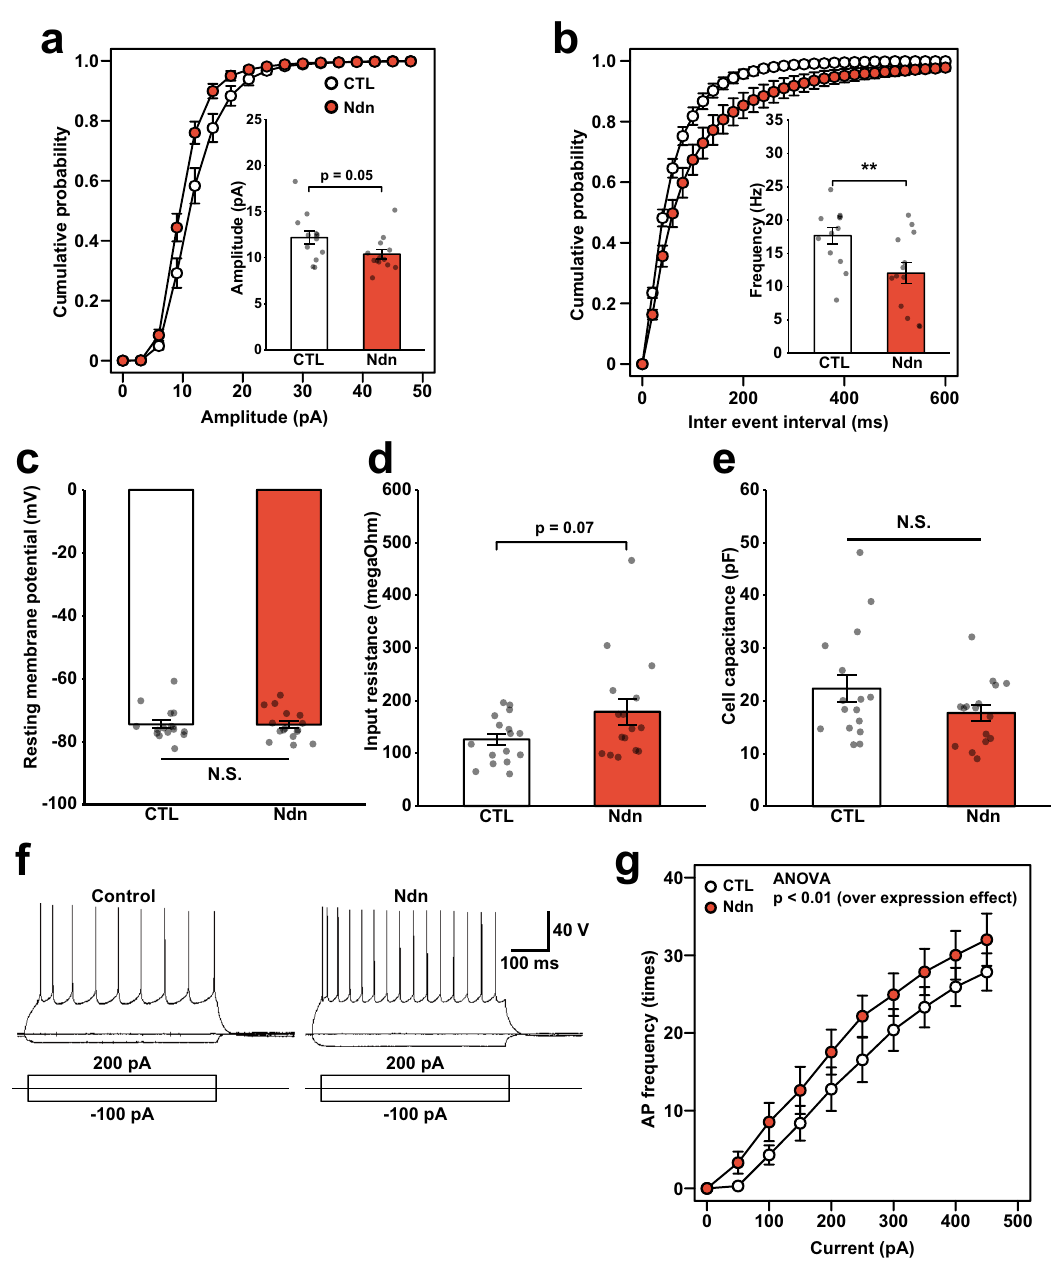
Fig. 4 Exogenous Ndn enhances neuronal excitability in cortical pyramidal neurons. a , b mEPSC recording in somatosensory cortex layer II/III pyramidal neurons overexpressing Ndn . Cumulative distributions and mean of mEPSC a amplitude, b inter-event intervals. Frequency: CTL vs. Ndn , p = 0.01 ( t -test). N = 13 neurons from six biologically independent mice for each group. Measurement of c resting membrane potential, d input resistance, e cell capacitance. N = 16 neurons from six mice for each genotype. f , g Action potential frequencies in Ndn -overexpressing neurons. f Representative traces of action potentials with injected currents. g The number of APs elicited by sequential current injections from 0 to 450 pA. N = 13 neurons from biologically independent six mice for each genotype. g ** p < 0.01 (two-way ANOVA; effect of overexpression: p = 0.0004, applied current p < 0.0001, interaction p = 0.9945). Data are represented as mean ± s.e.m. N.S. not statistically signi fi were able to detect the desired genomic deletion only when both may not re fl ect physiological conditions. Therefore, we examined guide RNAs were transfected (Supplementary Fig. 7b). We then whether removing a single copy of Ndn from original paternal performed cytoplasmic injection of Cas9 mRNA with two guide 15q dup mice is suf fi cient to restore the abnormal phenotypes RNAs to fertilized eggs obtained by crossing paternal 15q dup (Fig. 5a; named 15q dup Δ Ndn ). To produce this new mouse, we male mice and WT female mice. Twenty-nine pups with a applied the CRISPR-Cas9 system. We designed two guide RNAs duplication allele were born, of which 12 pups had one or two that encompassed a whole Ndn coding region (Supplementary deletions in the Ndn locus, as determined by conventional Fig. 7a; sgNdnProx and sgNdnDist) and introduced these guide genomic PCR. As further validation, we evaluated the target RNAs with a spCas9 -expressing plasmid to Neuro2a cell lines. We deletion by Southern blot and genomic PCR in mice